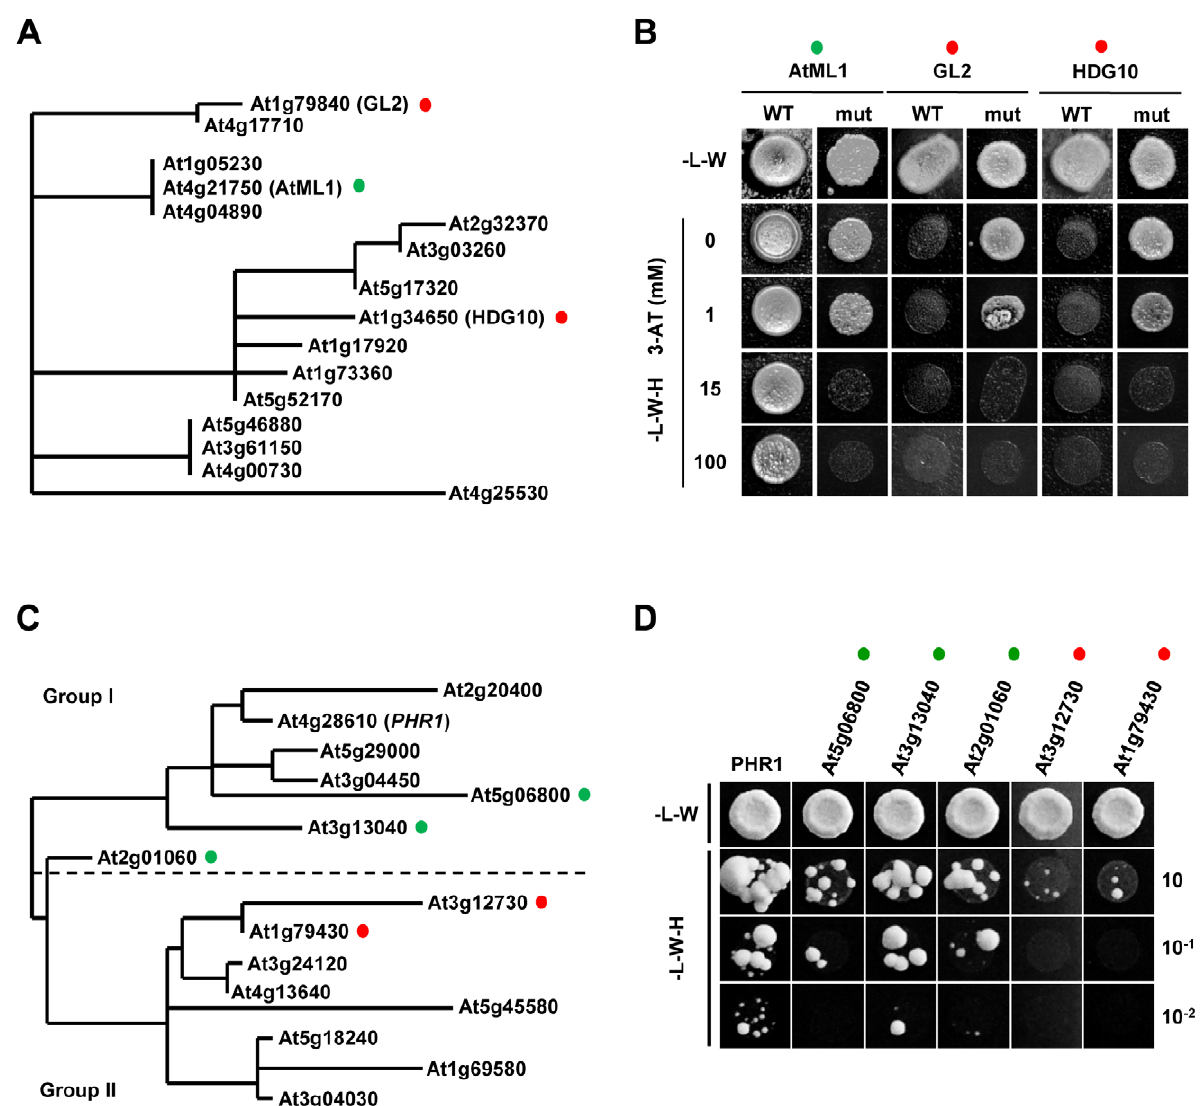
Figure 5. HD-ZIP subfamily IV and MYB-CC proteins show differential binding capabilities. ( A ) Phylogenetic tree of HD-ZIP class IV TF proteins from A. thaliana constructed using the Phylogeny.fr platform. TFs used in part (B) are indicated by green and red colored circles. ( B ) Yeast strains containing either the LIP1 element (WT) or a 2 bp mutation in the L1-box (mut), were mated to strains containing the AD-AtML1 , AD-GL2 or AD- HDG10 constructs. Diploid cells were grown on screening plates with increasing concentrations of 3-AT. Only the AtML1 protein is able to activate the reporter gene by binding to the WT element. ( C ) Phylogenetic tree of MYB-CC TF proteins from A. thaliana modified from a tree published elsewhere [12]. A dotted line separates Group 1 from Group 2 subfamily members characterized by having the MYB-CC domain at C or N-terminal position, respectively. TFs used in part (D) are indicated by green and red colored circles. ( D ) A yeast strain containing the IPS1 element was mated to strains containing the AD-PHR1 or AD-MYB-CC TFs. Diploid cells were grown on diploid and screening plates. Only PHR1 and PHR1-like proteins belonging to Group 1 were able to activate the reporter gene .Three serial dilutions of diploid cells were spotted.